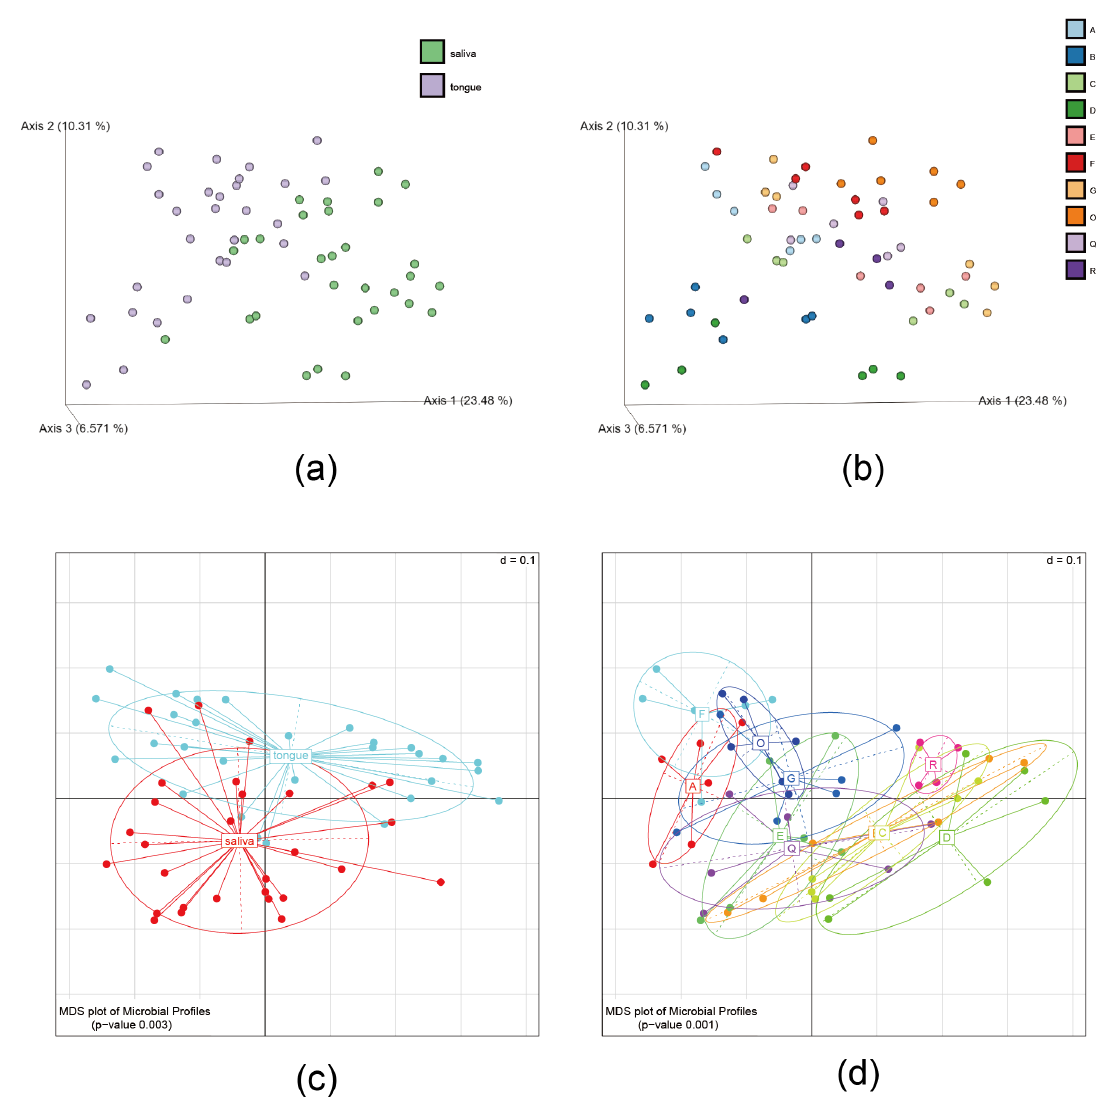
Figure 3. Beta diversity of the salivary and tongue microbiomes. ( a , b ) Three-dimensional principle co-ordinate analysis (PCoA) plots were generated with EMPeror using the full amplicon sequence variants (ASV) table. While only samples corresponding to D1 are displayed (n = 58), the PCoA analysis included all (116) samples. ( c , d ) multidimensional screening (MDS) plot of microbial profiles calculated based on generalized UniFrac distances using the clustered operational taxonomic unit (OTU) table. Each point indicates a sample. The points are colored according to the sampling site ( a , c ) or the participant from whom the sample was obtained ( b , d